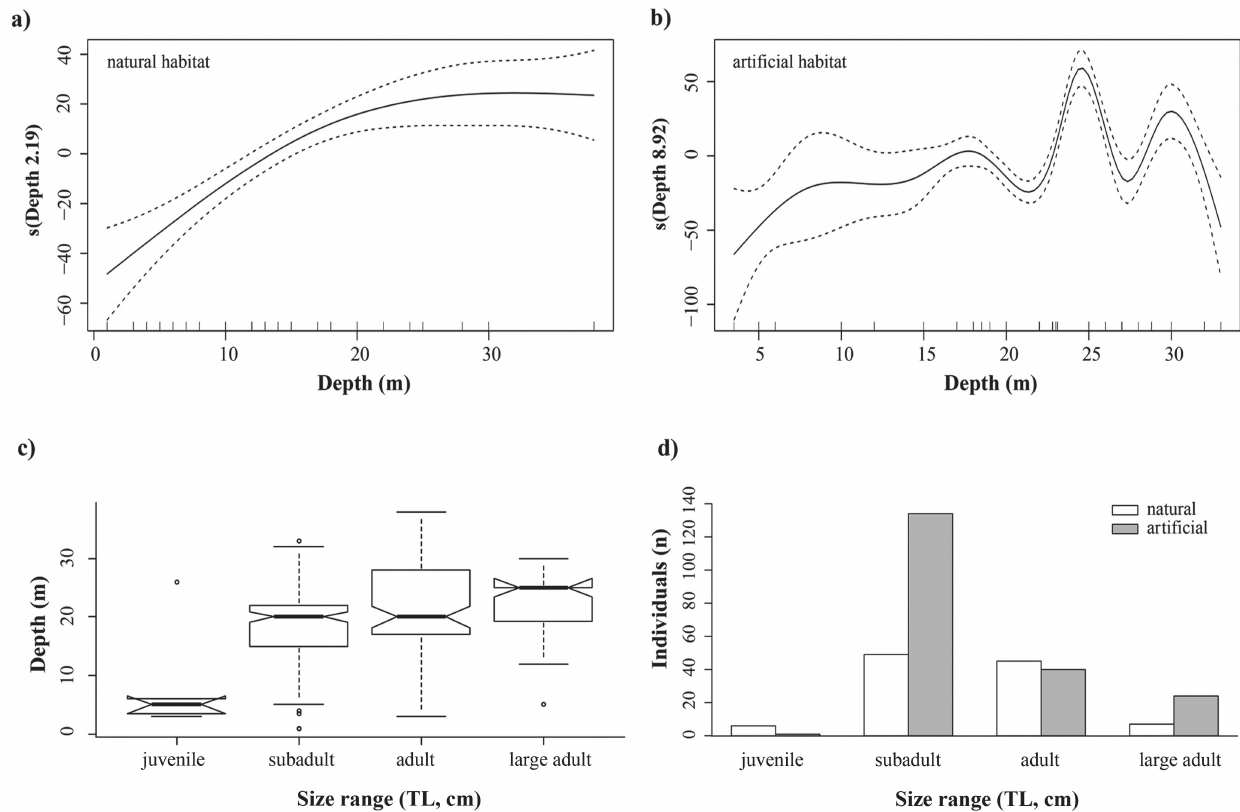
Fig. 4. Smoothing curve obtained by a generalized additive model using data from natural (a) and artificial habitats (b), showing the effect of sighting depth on Epinephelus itajara total length. Estimated smooth functions (solid lines) with 95% confidence interval (dashed lines) are shown for explanatory variable; y-axis= fitted function with estimated degrees of freedom in parenthesis; x-axis = variable range with rug plots indicating sampled values. (c) Boxplots of median depth among size categories for overall sightings; (d) number of goliath grouper observed at each size classes, at natural and artificial habitats. Size categories: juvenile (<50 cm), subadult (50 – 100 cm), adult (101 – 150 cm) and large adult (151 – 200 cm). Numbers above each box represent total number of individuals per size range